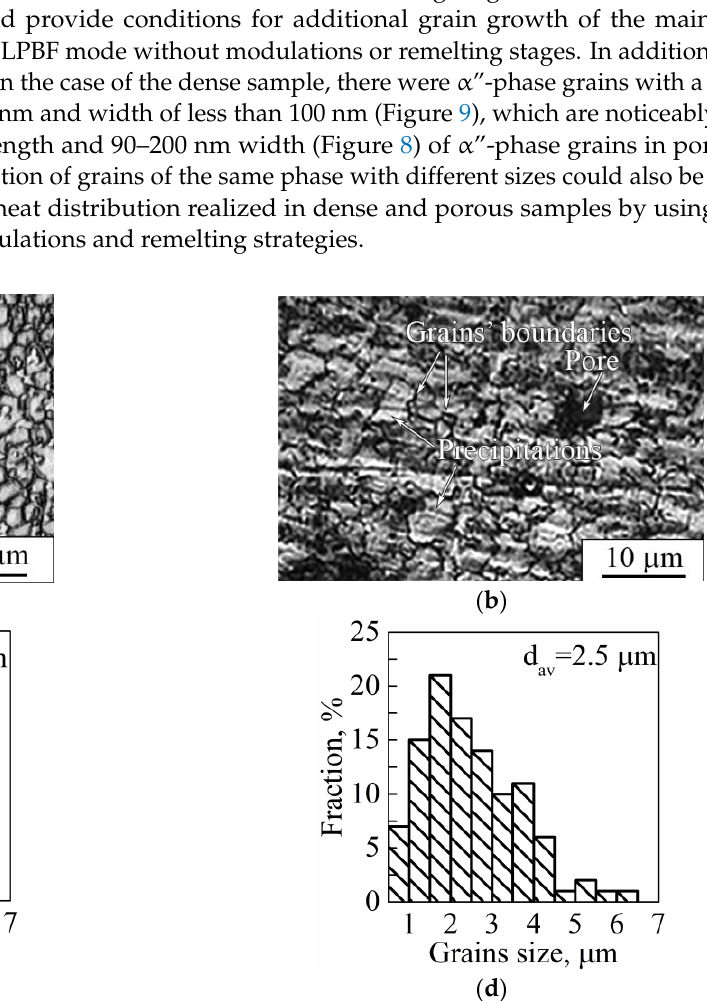
Figure 15. Optical images of ( a , b ) microstructure and ( c , d ) grain size distribution of ( a , c ) dense and ( b , d ) porous samples (d av is the average grain size).